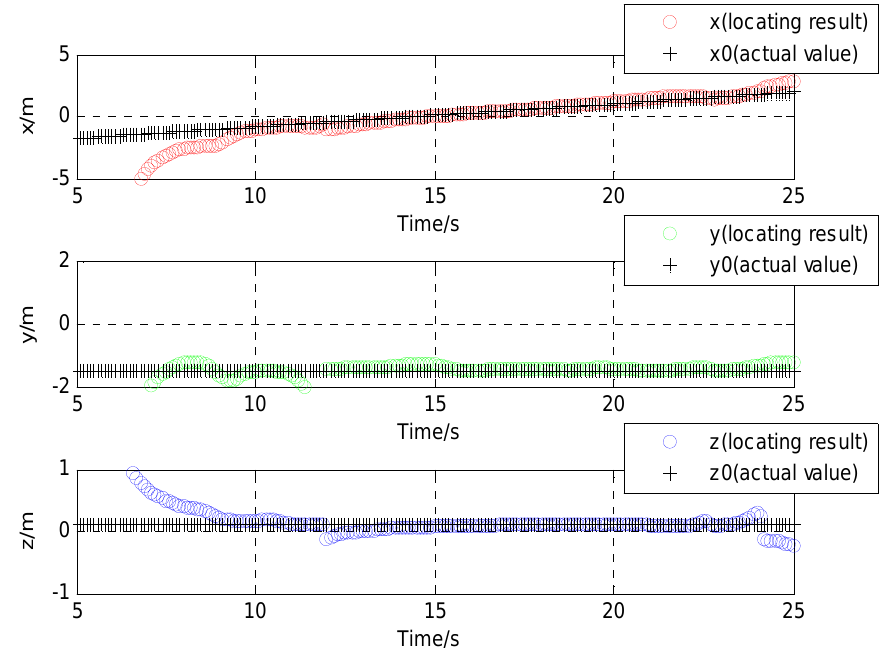
Figure 14. Contrast of location result and actual value in three directions of the experimental tests.